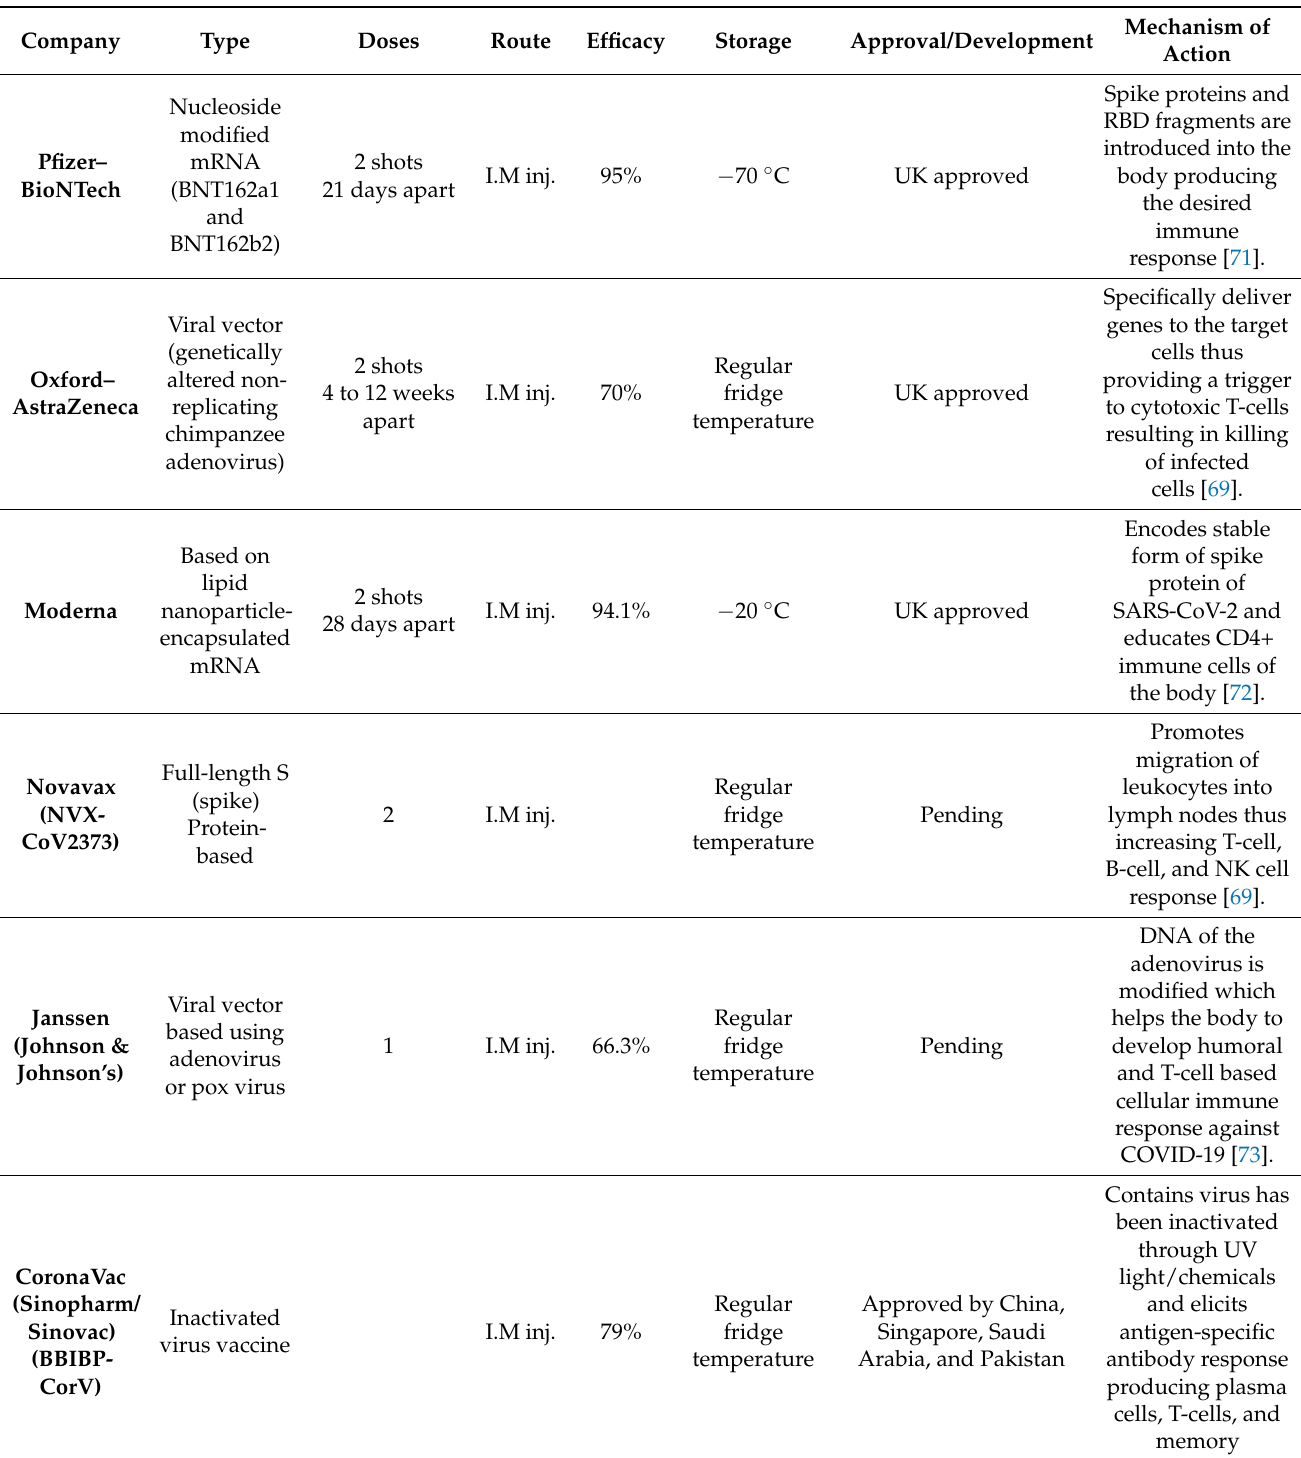
Table 5. Sources, respective companies, and approval status of various COVID-19